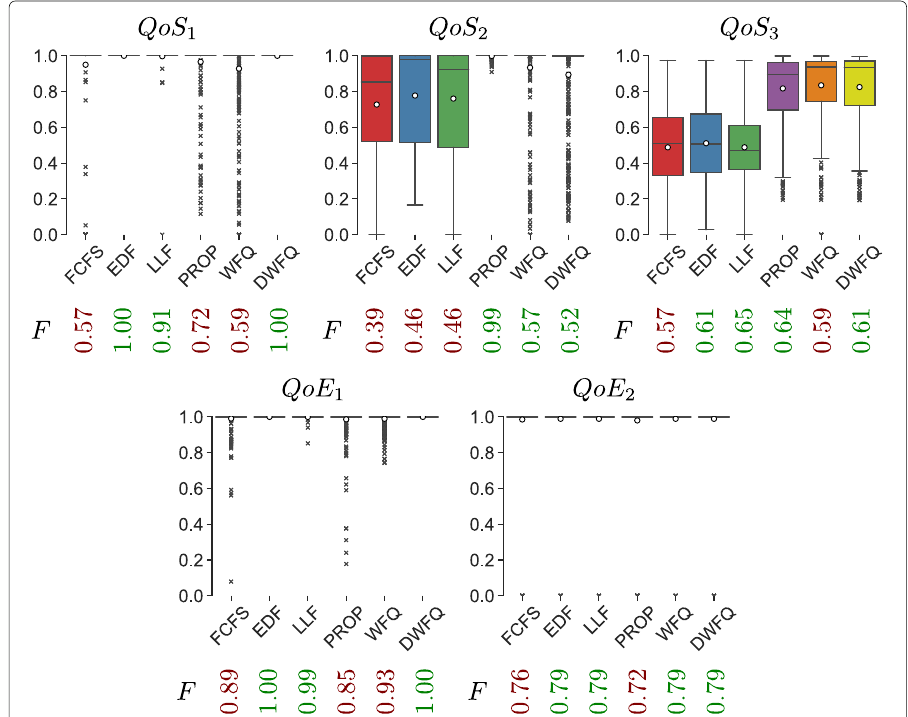
Fig. 7 QoS and QoE metrics of the different queuing policies for all 557 charging services. The box plots show the result distribution among the charging services and the circle denotes the average value. Below the box plots, the achieved fairness index F is given. 22 kW wall-boxes with 100% transformer limitation. Note that for QoS 1 , QoE 1 and QoE 2 most of the charging service have very high service quality, hence the boxes are very tiny near to 1